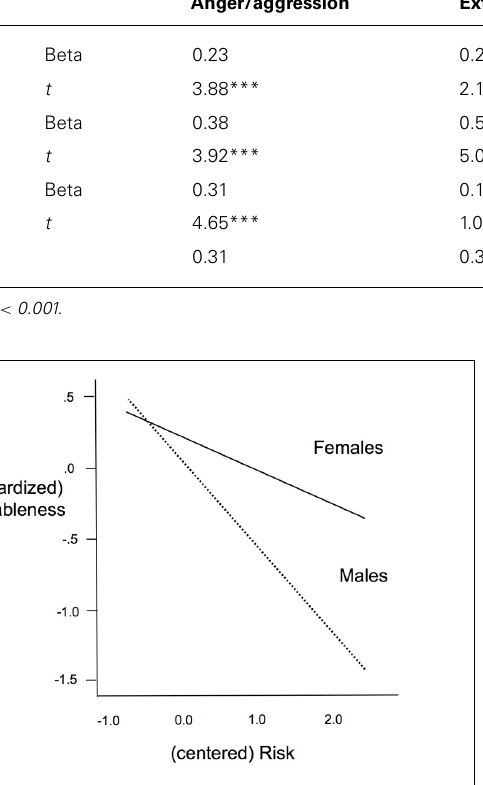
FIGURE 2 | Interaction between gender and risk in prediction of agreeableness latent